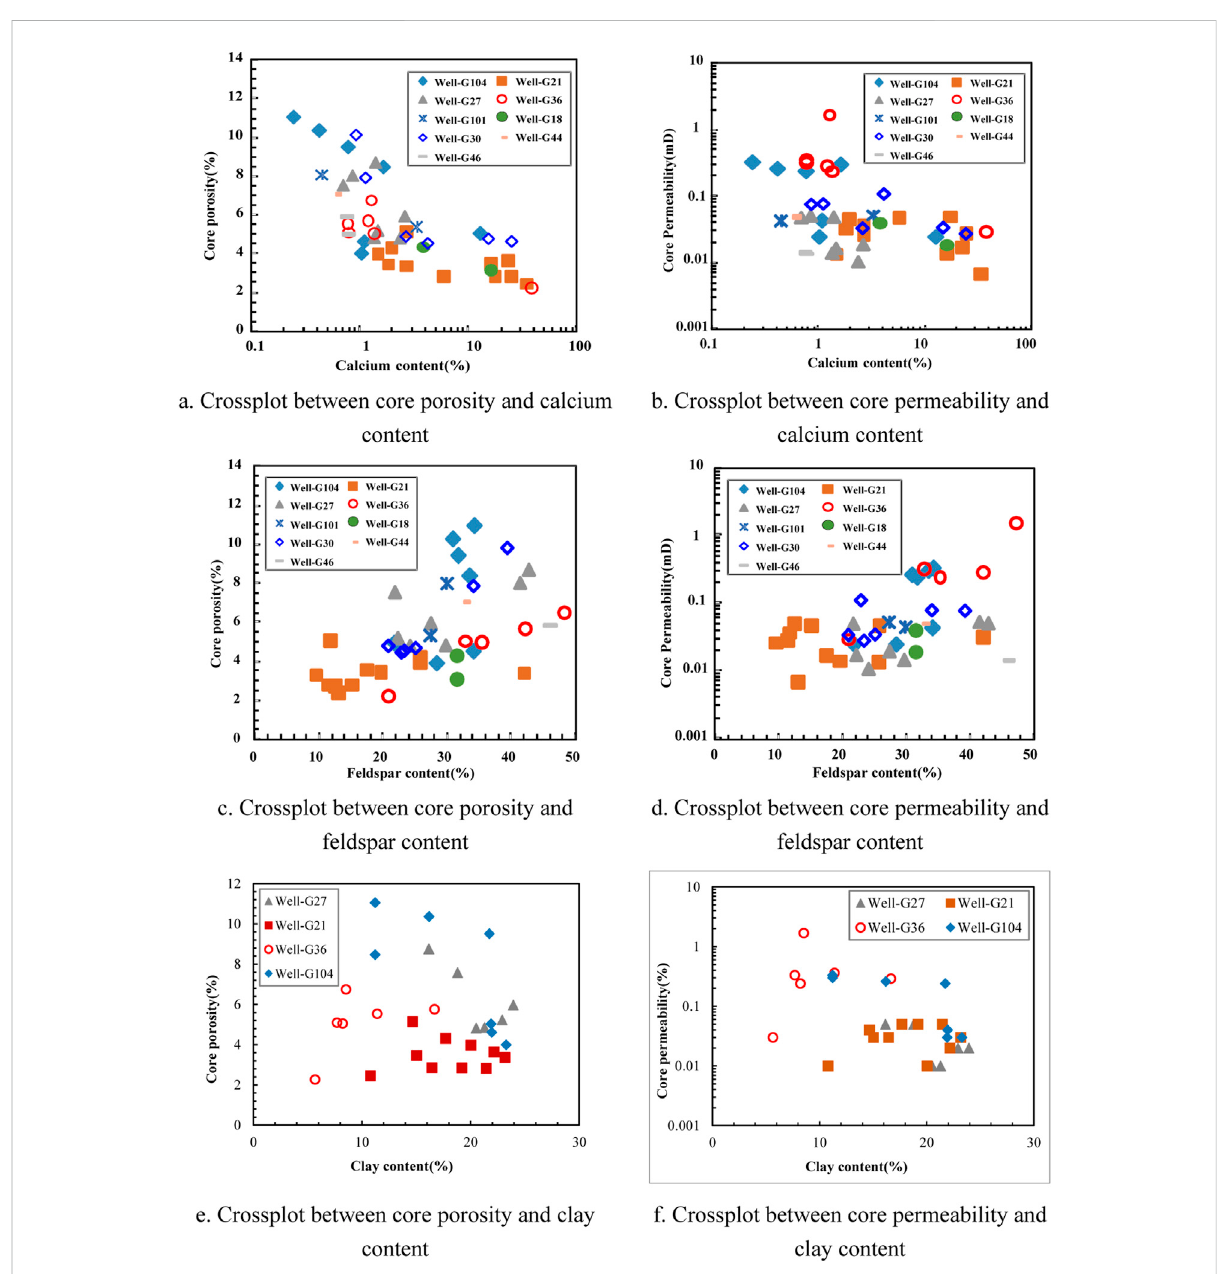
FIGURE 5 Correlation between feldspar, calcium, and clay content with porosity and permeability. (A) Crossplot between core porosity and calcium content. (B) Crossplot between core permeability and calcium content. (C) Crossplot between core porosity and feldspar content. (D) Crossplot betweencorepermeabilityandfeldsparcontent. (E) Crossplotbetweencoreporosityandclaycontent. (F) Crossplotbetweencorepermeabilityand clay